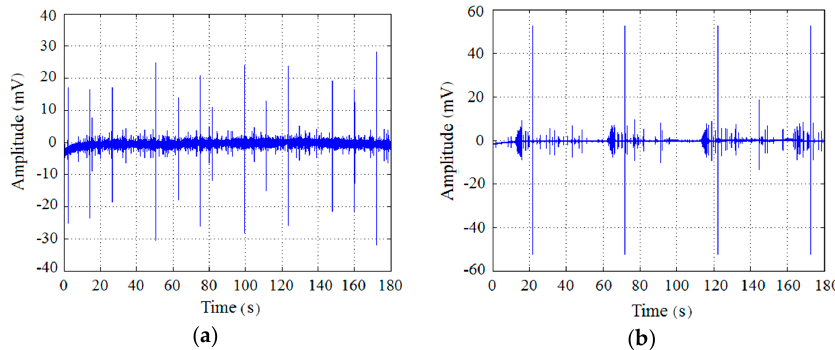
Figure 17. AE signals with periods ( a ) 12.5 s and ( b ) 50 s associated with scoring and roughness on the roller surface or a kiln bandage.